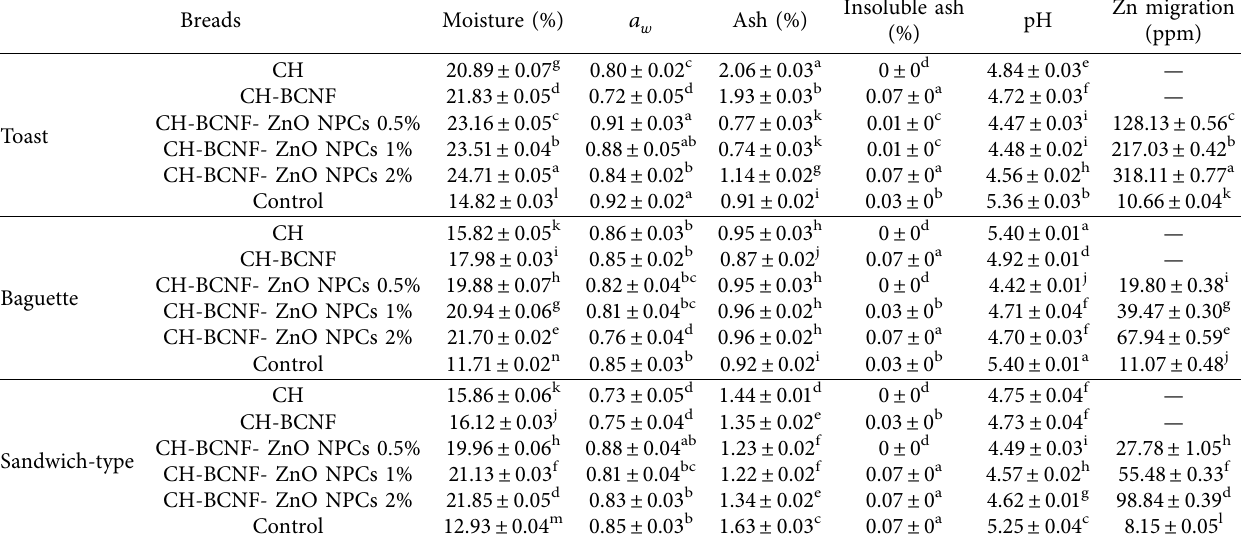
Table 3: Chemical properties of the diferent breads. Breads